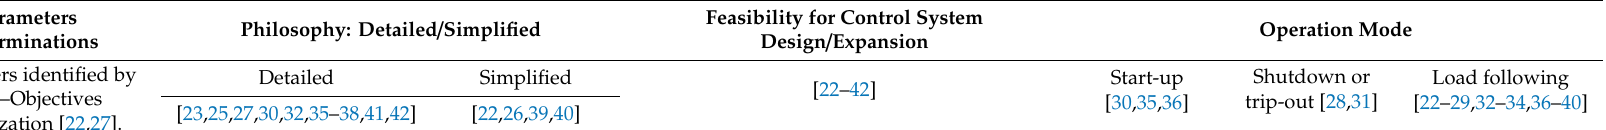
Table 1. Summary of gas turbine (GT) physical modeling reviewed